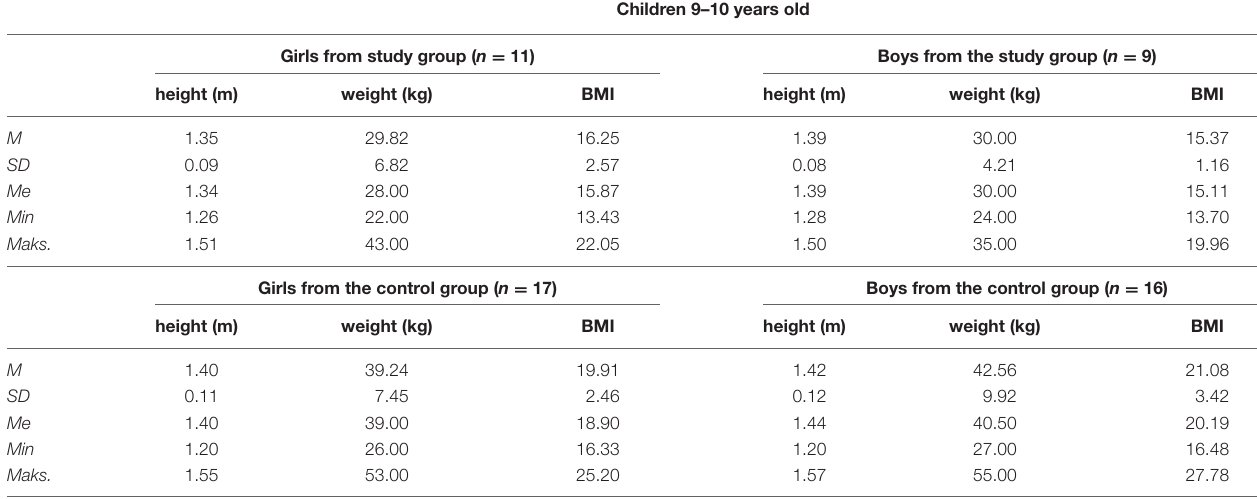
TABLE 2 | Anthropometric indicators among 9–10-year-old children depending on the occurrence of chest pain and gender.